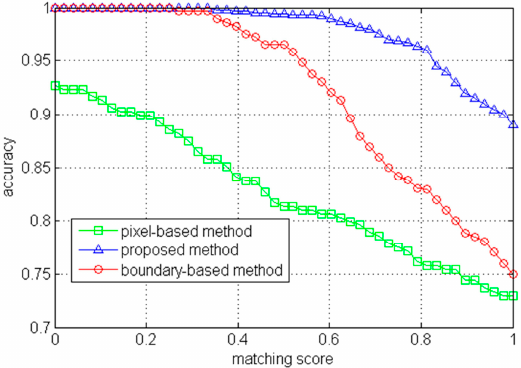
Figure 9. Segmentation accuracy with different methods on the KITTI road benchmark (unmarked lane subset of